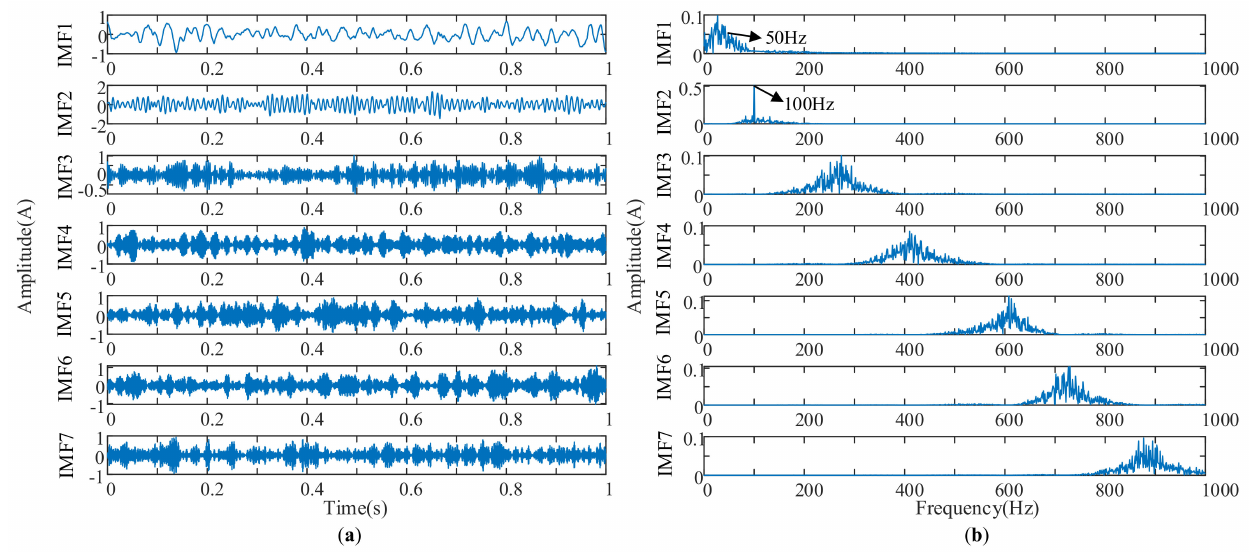
Figure 8. IMF components after VMD decomposition: ( a ) Time − domain; ( b ) frequency domain.